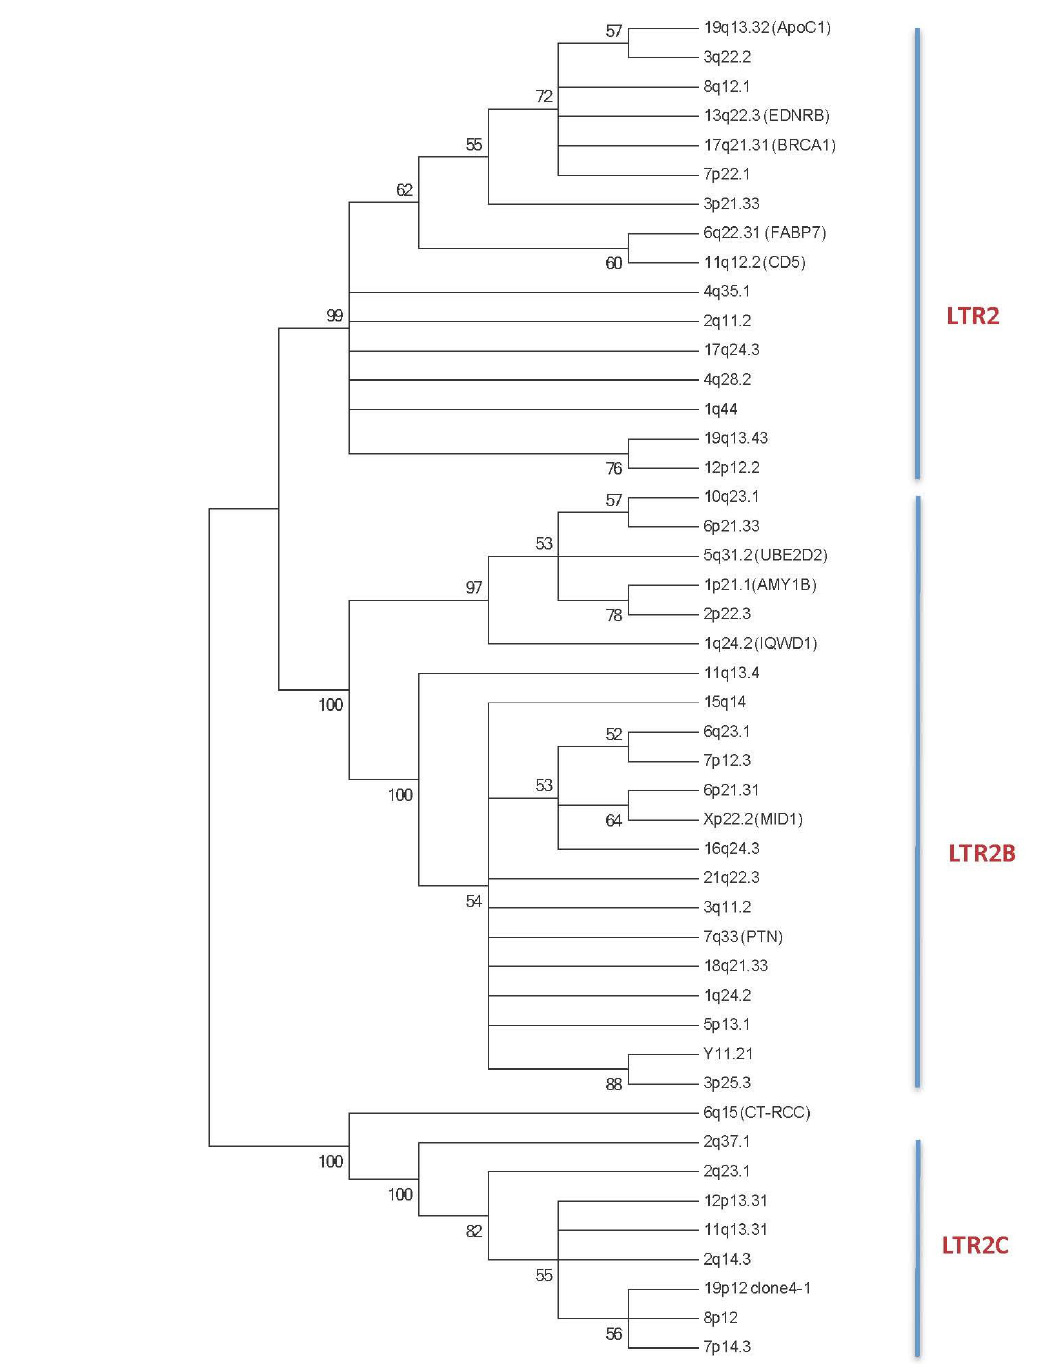
Figure 1. The phylogenetic tree of the 5’ LTR HERV-E sequences reveals three main subgroups: LTR2, LTR2B and LTR2C. Phylogenetic analyses were inferred using the Maximum Parsimony Methods on the ClustalW Multiple alignment of 46 HERV-E 5’LTR nucleotide sequences. The most parsimonious tree is shown; it shows that the 46 HERV-E LTRs are segregated into 3 distinct subgroups. Bootstrap values greater than 50% are shown. The 5’ HERV-E LTR sequences are identified with their respective human chromosomal locus location (See Experimental Section plus Table 1). When known, the gene used for alternative transcript usage is